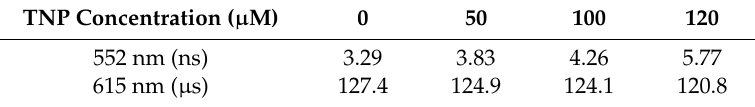
Figure 10. ( A ) Emission decay dynamics of RS6h@EuBTC (615 nm) under various TNP concentrations; ( B ) emission decay dynamics of RS6h@EuBTC (552 nm) under various TNP concentrations. Table 1. Emission lifetimes of RS6h@EuBTC under various TNP concentrations. TNP Concentration ( µ